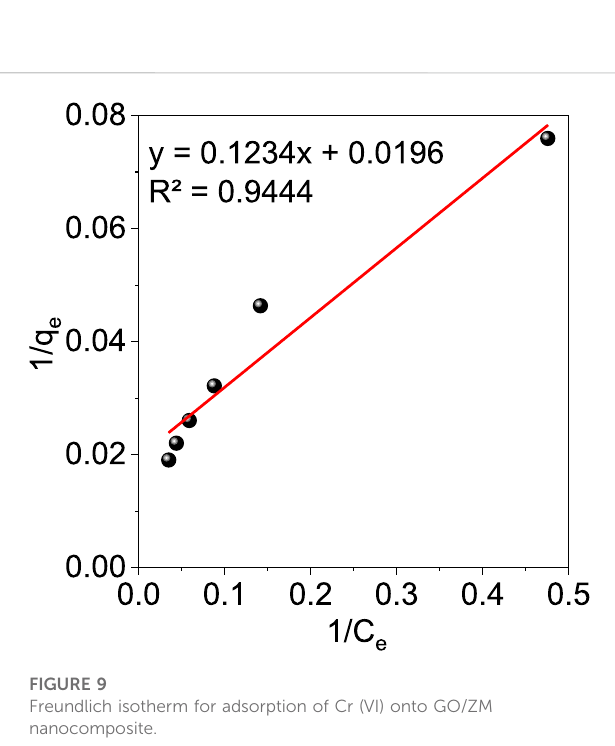
FIGURE 9 Freundlich isotherm for adsorption of Cr (VI) onto GO/ZM nanocomposite.